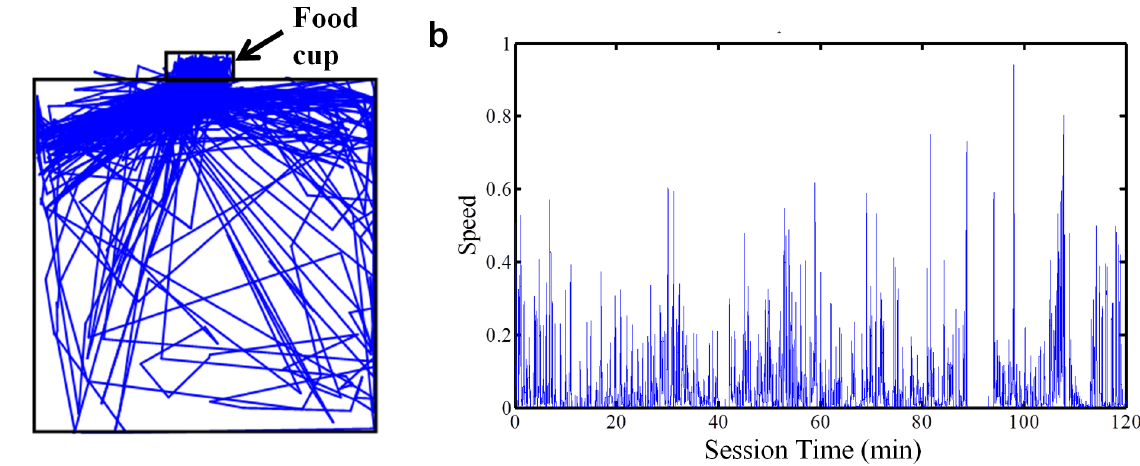
Figure 13. Mice are active throughout the recording session. To ensure that motivational modulation was not caused by mice falling asleep or losing interest in the pellets, we used video tracking to record the position of mice during recording sessions. Mice spent most of their time near the food cup ( a ). Speed was calculated (pixels per frame) throughout the session. Mice remained consistently active for the entire two-hour session ( b ).